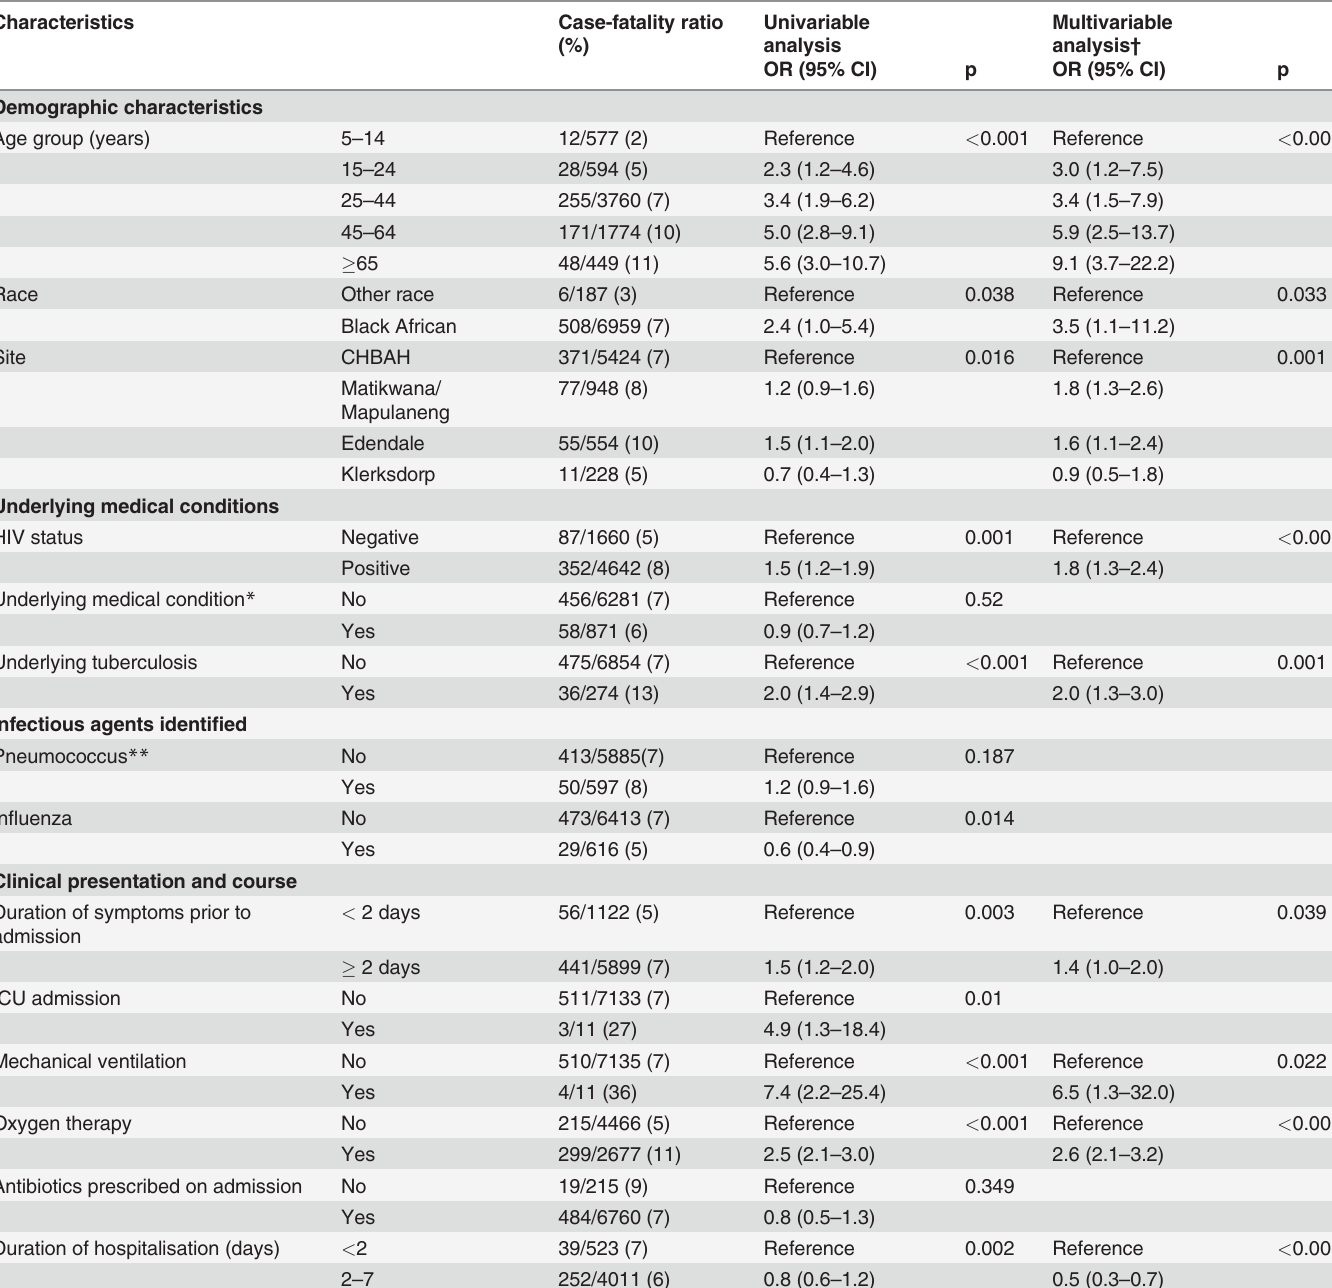
Table 4. Factors associated with death amongst patients aged (cid:1) 5 years hospitalised with severe acute respiratory illness (SARI) at four sentinel surveillance sites, South Africa, 2009 – 2012 †